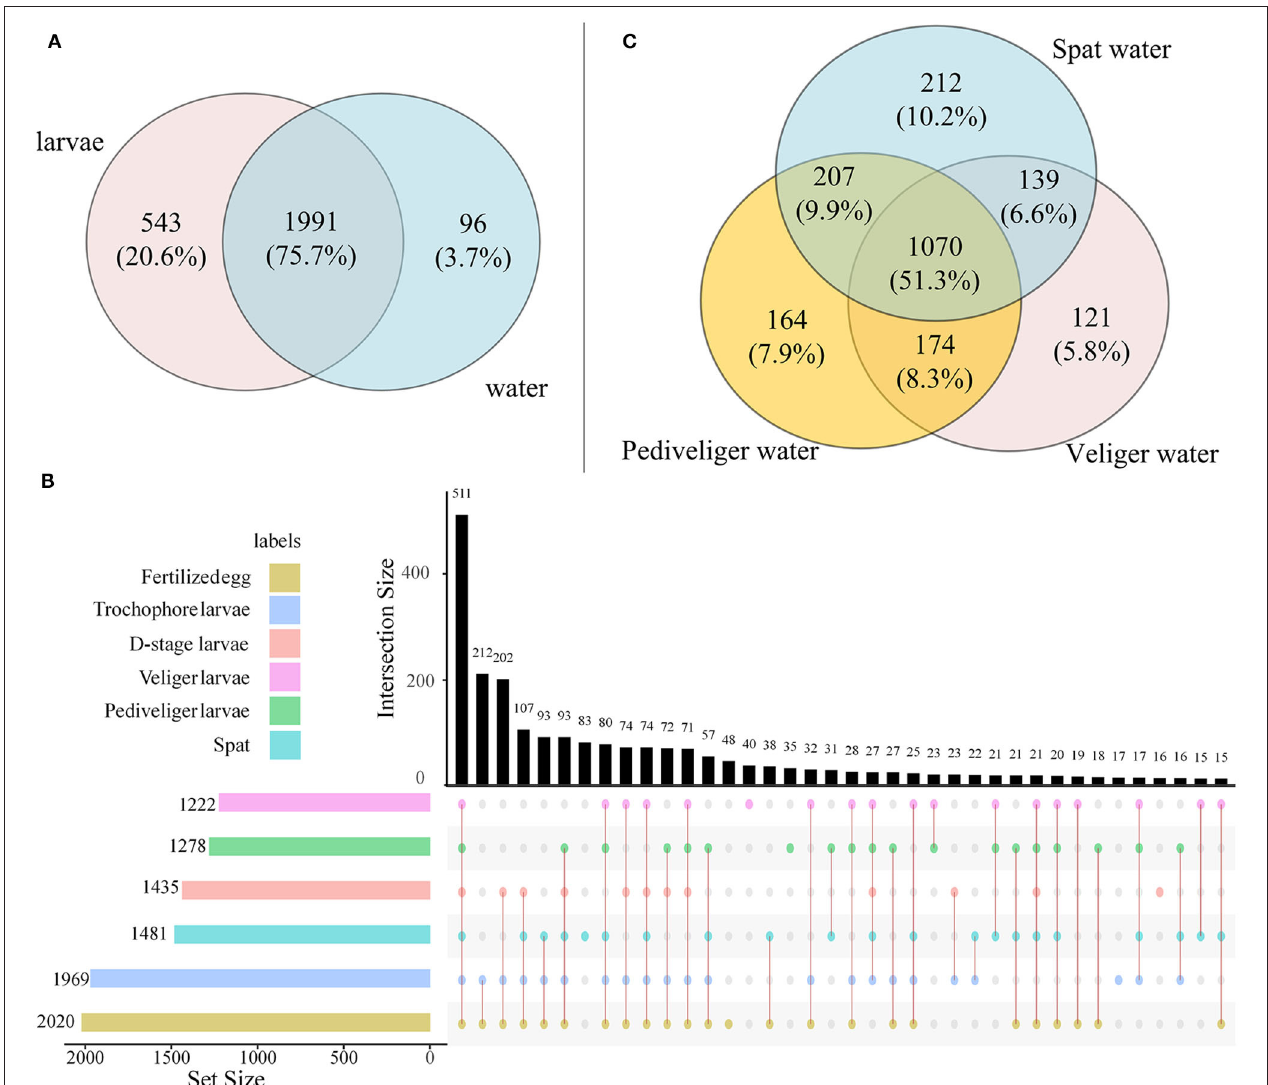
FIGURE 1 | The Venn diagram shows the OTUs that are unique and shared among developmental stages in larvae and rearing water. (A) Number of OTUs shared between larvae and rearing water samples; (B) Upset plot displays the number of detected OTUs in larvae at each developmental stage (horizontal bars) and unique or shared OTUs (individual or connected points, respectively), in larvae among developmental stages; (C) Number of OTUs shared in rearing water among veliger, pediveliger, and spat